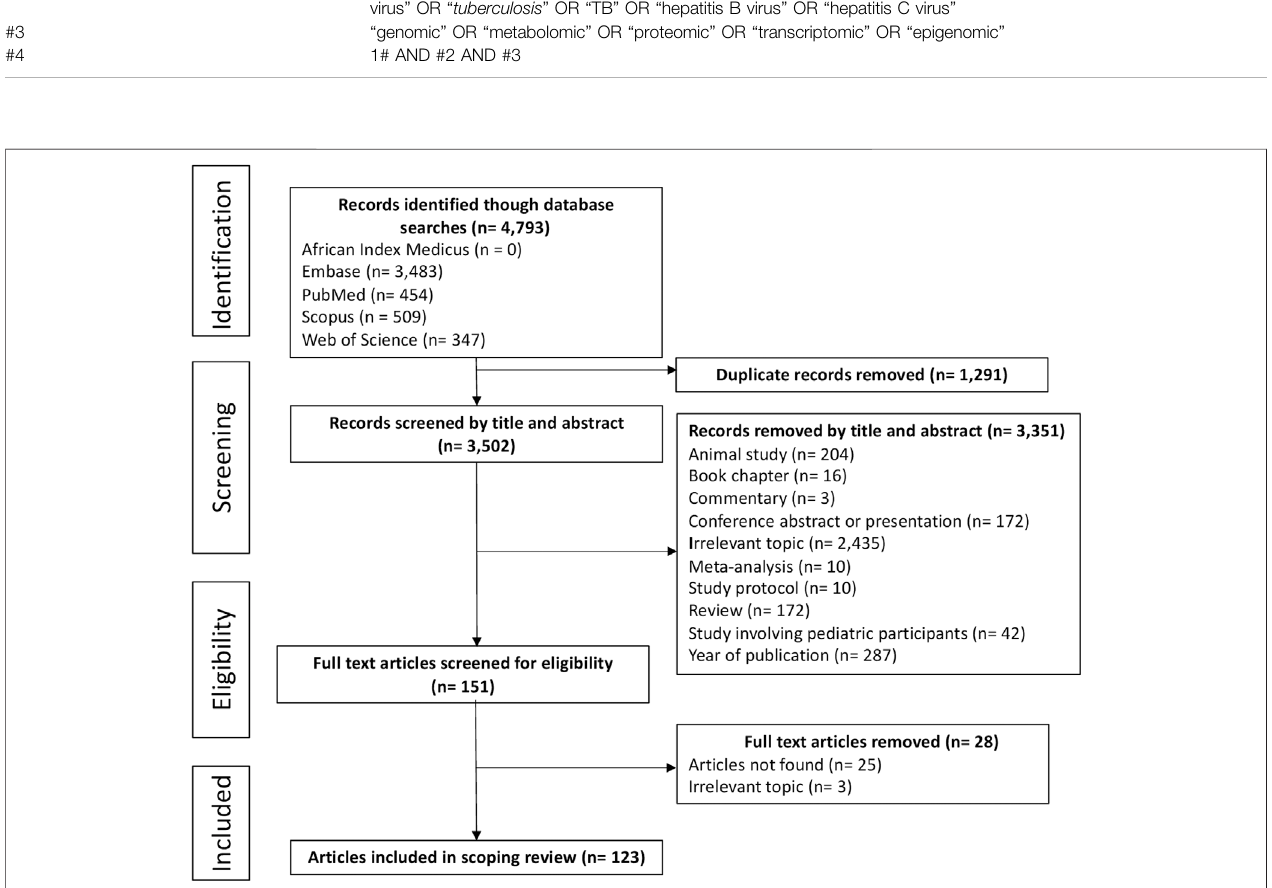
FIGURE 1 | Article selection process according to PRISMA-ScR